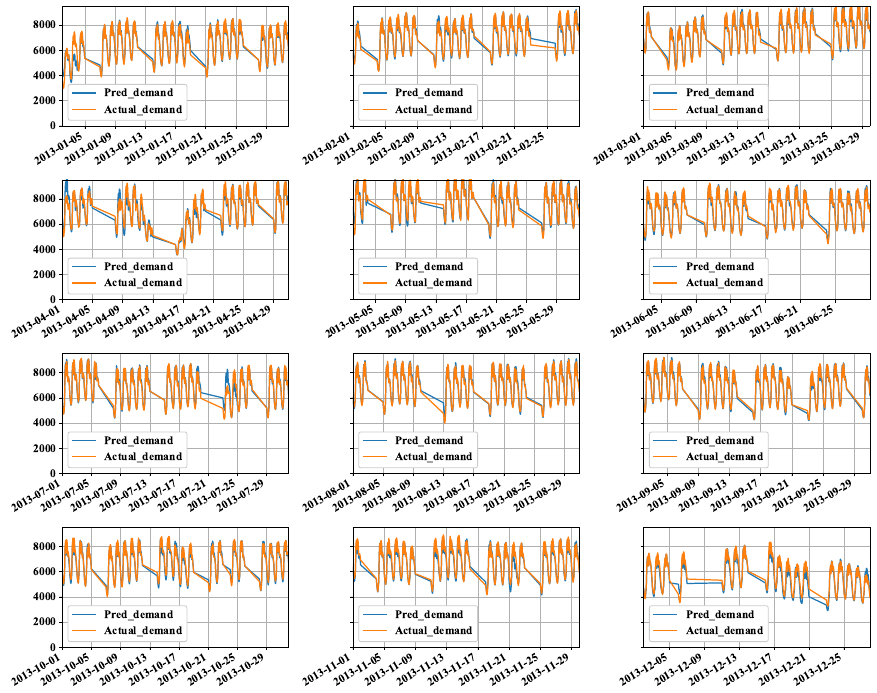
Figure A8. Forecasting performance of OLS (Scenario 1).